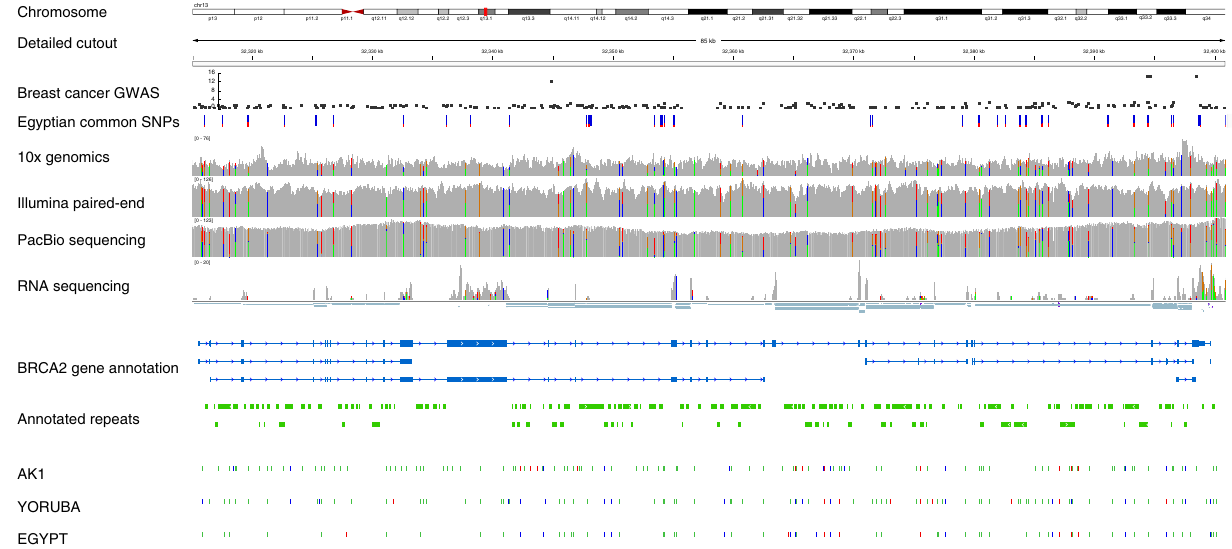
Fig. 4 Integrative view of Egyptian genome reference data for the gene BRCA2, which is associated with breast cancer. The rows denote from top to bottom: Genome location on chromosome 13 of the magni fi ed region for BRCA2 ( fi rst and second row); GWAS data for breast cancer risk 54 ; Variants that are common in the cohort of 110 Egyptians; Read coverage of genetic region based on 10x Genomics, Illumina paired-end and PacBio sequencing data; Coverage and reads of RNA sequencing data; BRCA2 gene annotation from Ensembl; Repeats annotated by REPEATMASKER; SNVs and indels identi fi ed by comparison of assemblies AK1, YORUBA and EGYPT with GRCh38. The colors denote base substitutions (green), deletions (blue) and insertions (red). The region above is included in a larger phase block chr13:25,831,216-33,523,430 and the corresponding variant phasing for the EGYPT individual is displayed in Supplementary Fig.